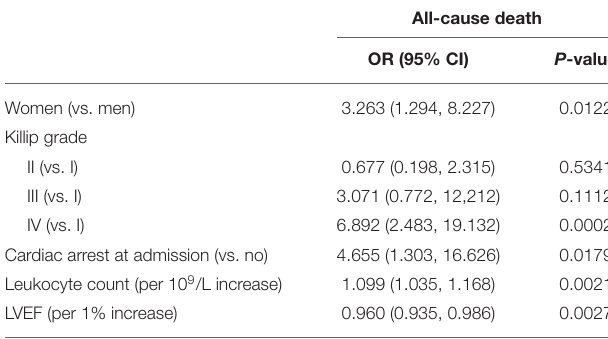
TABLE 4 | Follow-up outcomes of patients in different age groups. TABLE 5 | Multivariate analysis of in-hospital mortality in young patients.